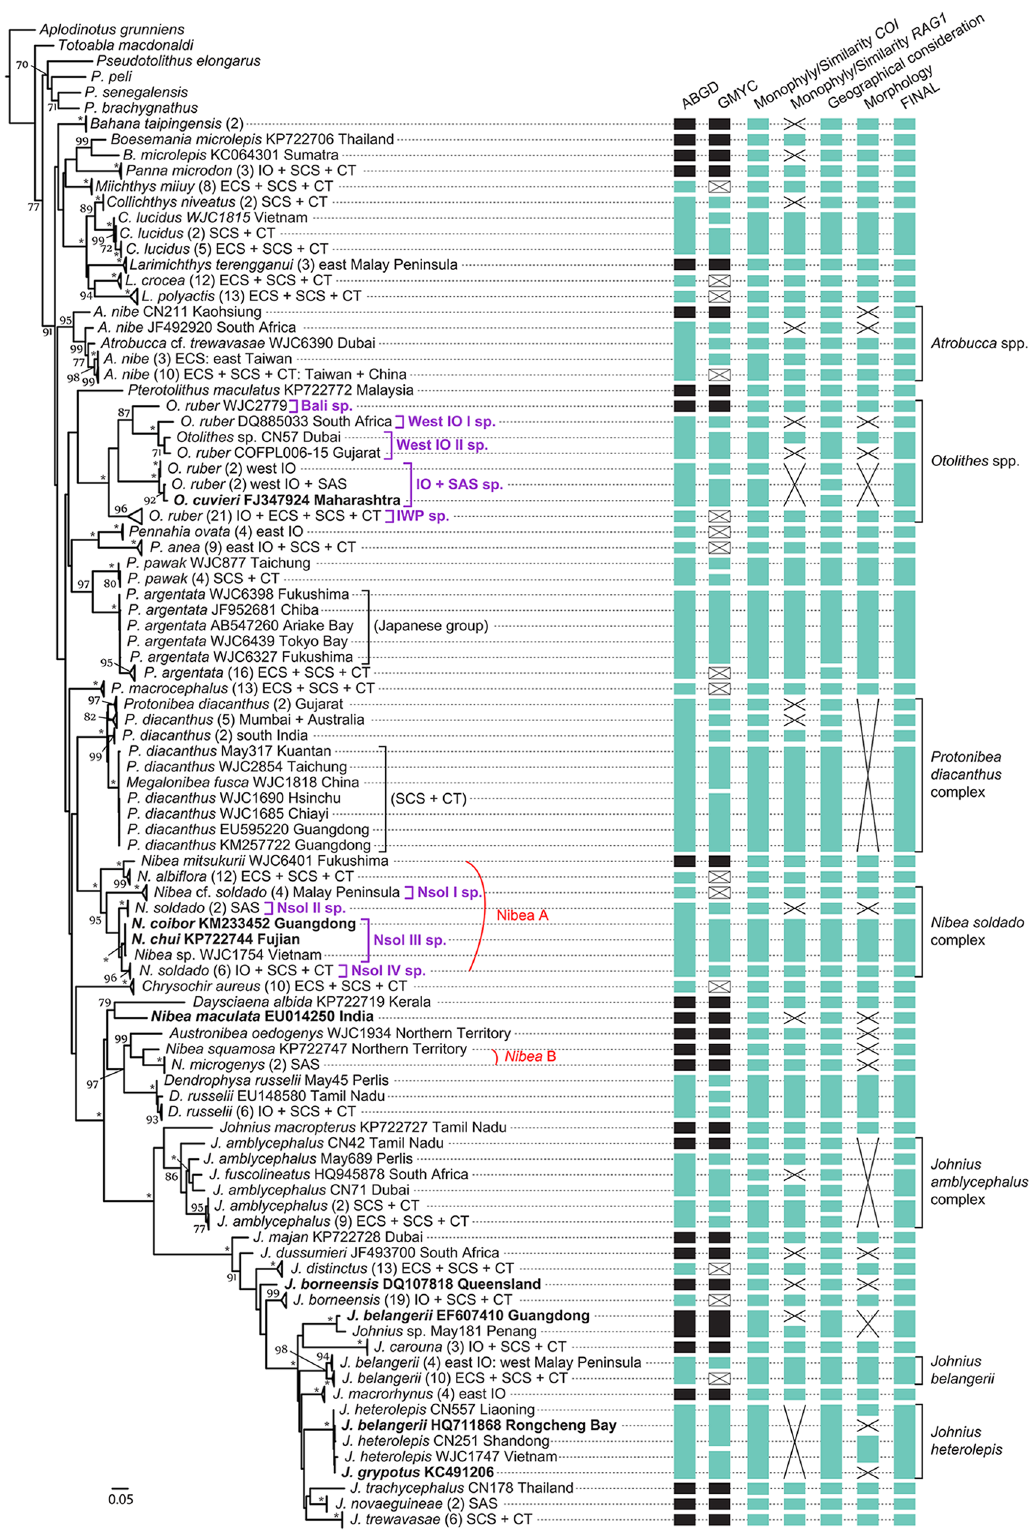
Fig 2. Summarized phylogenetic tree of the IWP sciaenids inferred by partitioned maximum-likelihood method with GTR+ Γ + I nucleotide substitution model based on the COI gene dataset and results from species